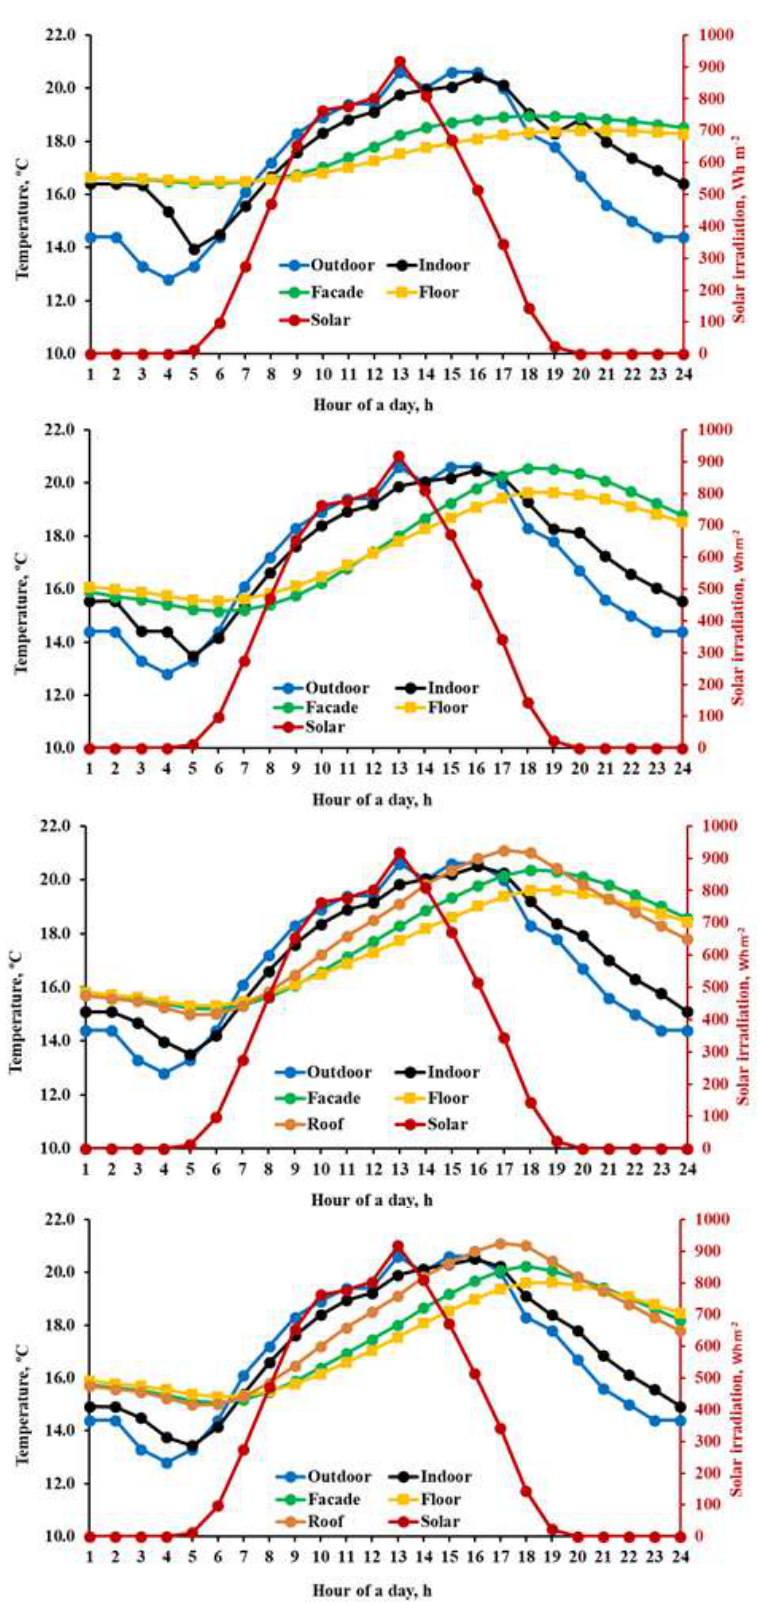
Figure 6. Solar irradiation, and outdoor air, façade, floor and roof temperature, and indoor air temperature for different rooms for 24 h.